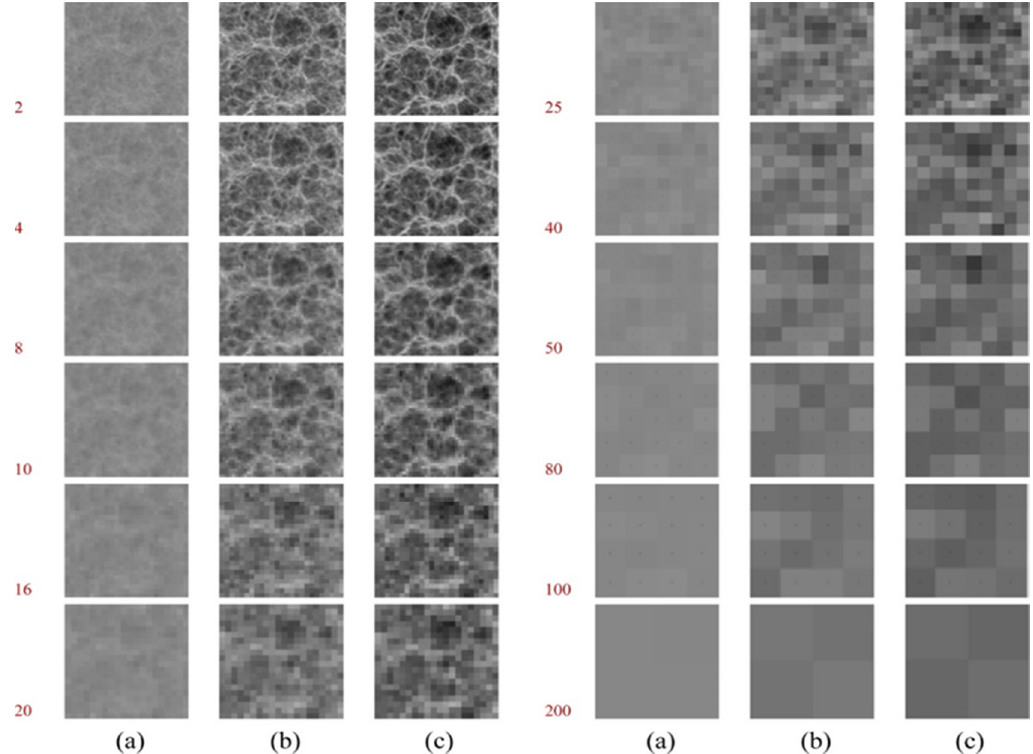
Figure 12. Example of the stochastic analysis of a 2D picture, in escalating spatial scales, as shown in red color on the left. The variability of the grouped pixels at different scales are used to construct the climacogram’s images; ( a – c ) correspond to different time frames as given in Figure 11. Source: [39].